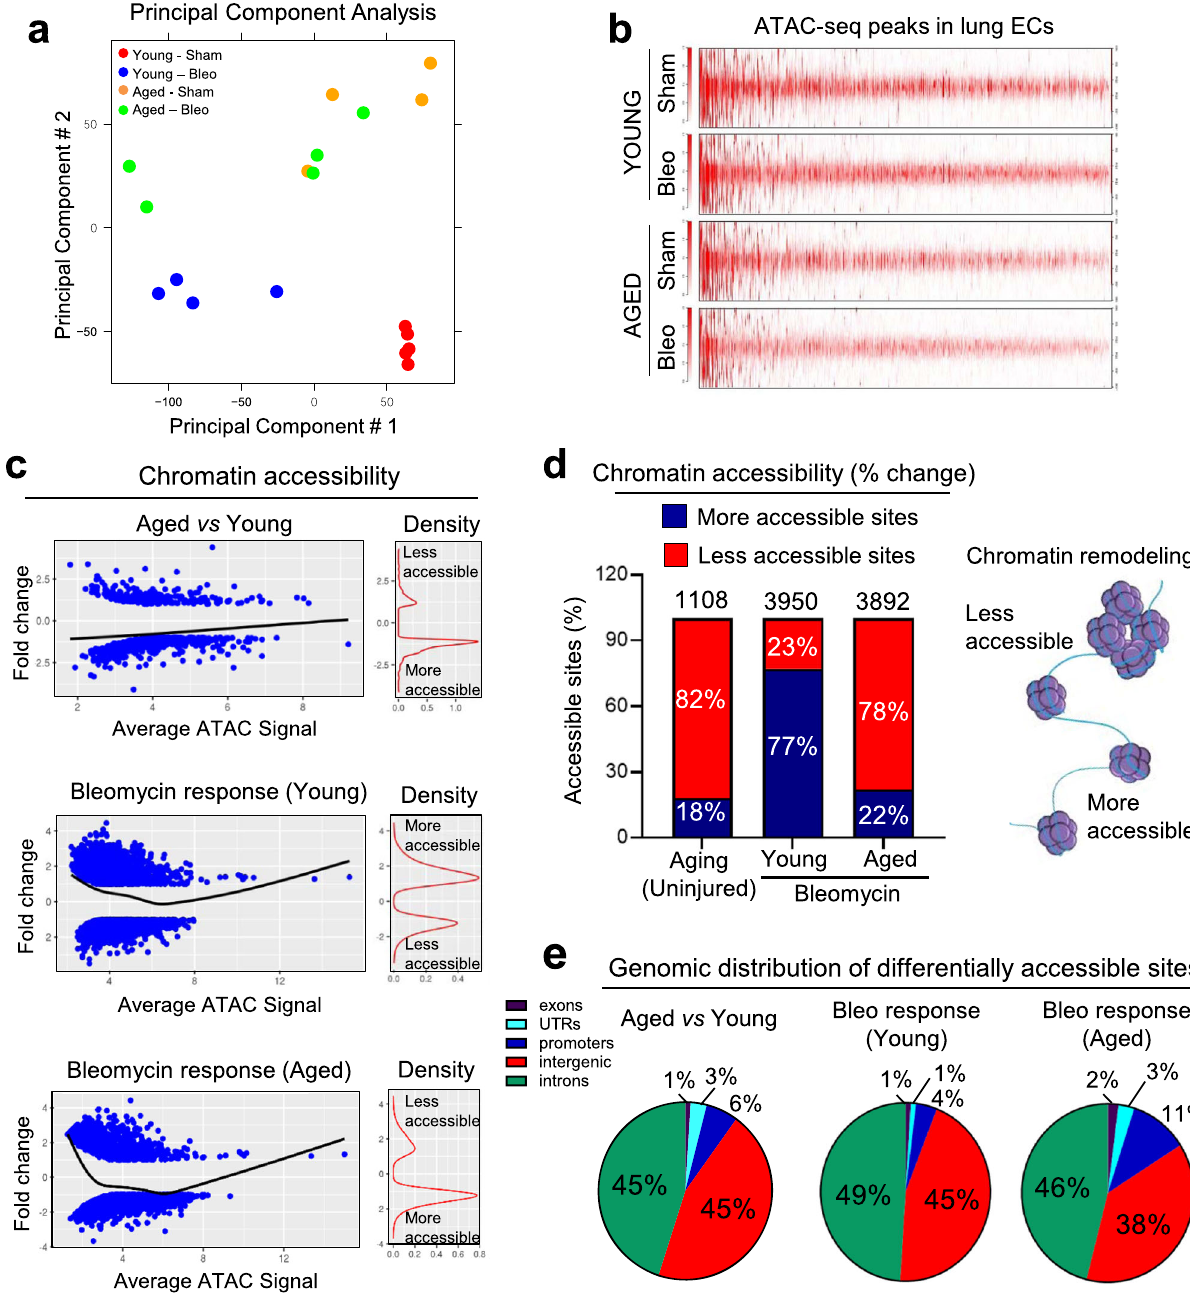
Fig. 1 The landscape of chromatin accessibility in young and aged mouse lung ECs. a Principal component analysis (PCA) of accessible loci as determined by ATAC-seq of freshly sorted lung ECs from young and aged mice, either Sham operated and 30 days after intratracheal Bleomycin delivery. Each dot represents an individual mouse (Young Sham 2-month-old, N = 5; Young Bleo 2-month-old, N = 4; Aged Sham 18-month-old, N = 4; Aged Bleo 18-month-old, N = 5). b Genome-wide ATAC-seq peaks in lung ECs. Each column represents one peak. The color represents the intensity of chromatin accessibility (dark red/more accessible and light red/less accessible). c Relative changes of chromatin accessibility in aged vs young ECs from sham mice, and in injured young and injured aged ECs vs young sham. Each dot represents one ATAC-seq peak. Black line in the left panel indicates average fold changes of peaks with the same ATAC-seq intensity. The density of open and closed peaks is shown under the density curve in the right panel. d Overall percentage of accessible chromatin sites in aged vs young ECs from sham mice, and in injured young and injured aged ECs vs young sham. e Genomic distribution of differentially accessible regions between young and aged lung ECs. The majority of differentially accessible sites were in introns and intergenic